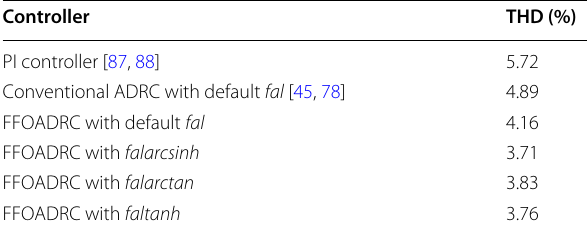
Table 5 THD% of the stator current using different controllers